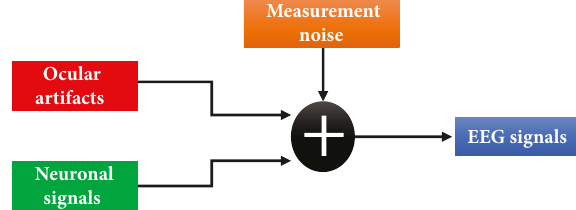
Figure 2: General approach for generation of EEG